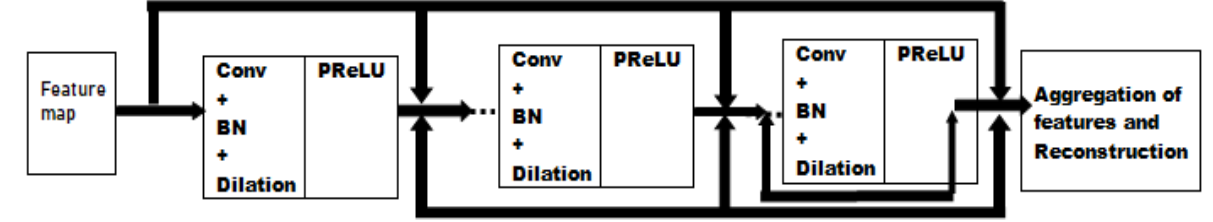
Figure 2. Residual network framework.